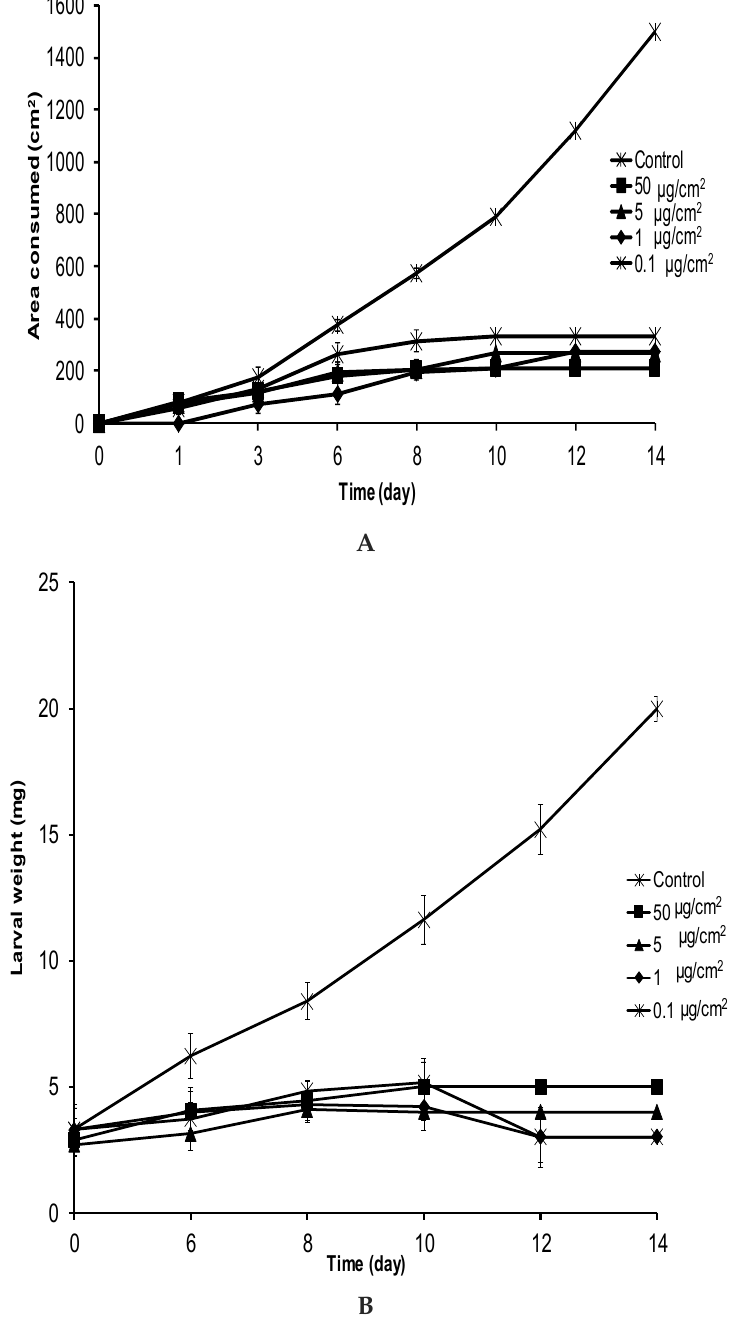
Figure 4. Average leaf area consumed ( A ) and average body weight ( B ) of E. paenulata larvae fed on leaves treated with 1 in a no-choice feeding assay. Error bars <30 and <2 for area consumed and body weight, respectively, are embedded in symbols.